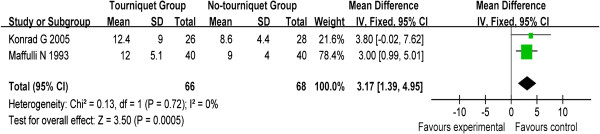
Meta-analysis of hospital stays of patients in the tourniquet and non-tourniquet groups.